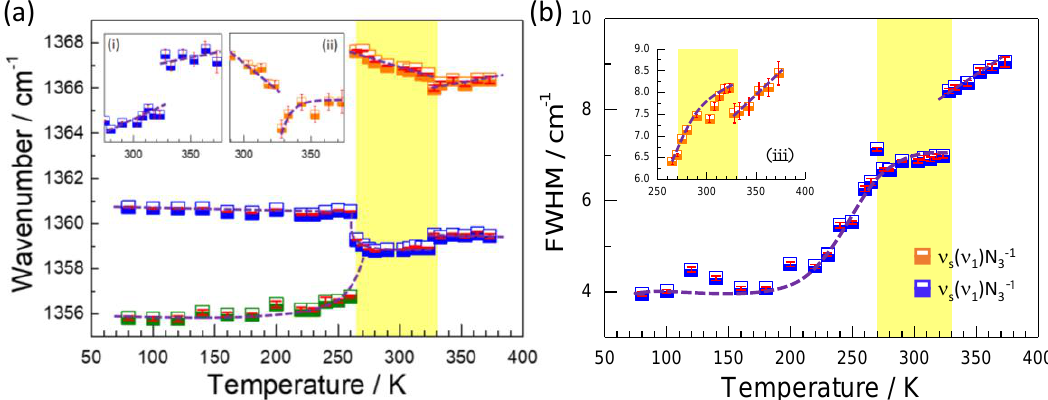
Figure 6. Temperature dependence of the wavenumber ( a ) and full width at half-maximum (FWHM) ( b ) of the most representative modes in the region of medium frequencies. The insets (i) and (ii) indicate details of the wavenumber behavior around the second structural phase transition; meanwhile, the inset (iii) indicates details of the multiple phase transitions observed in the width of the mode 1366 cm −1 .